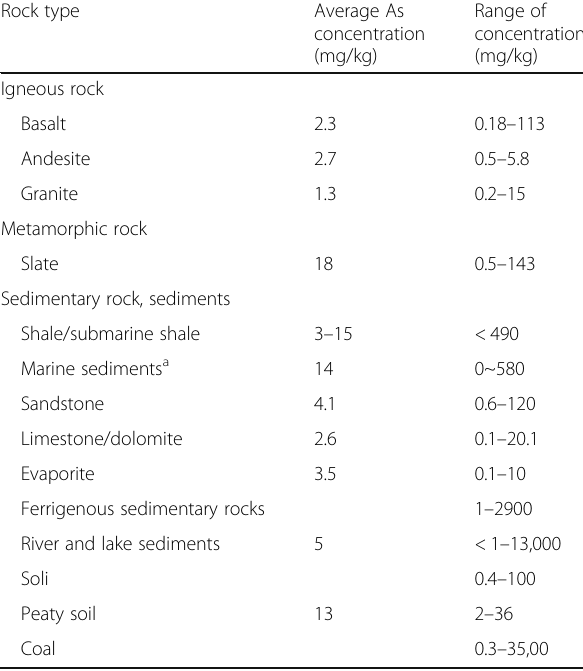
Table 1 Arsenic concentrations of rocks and